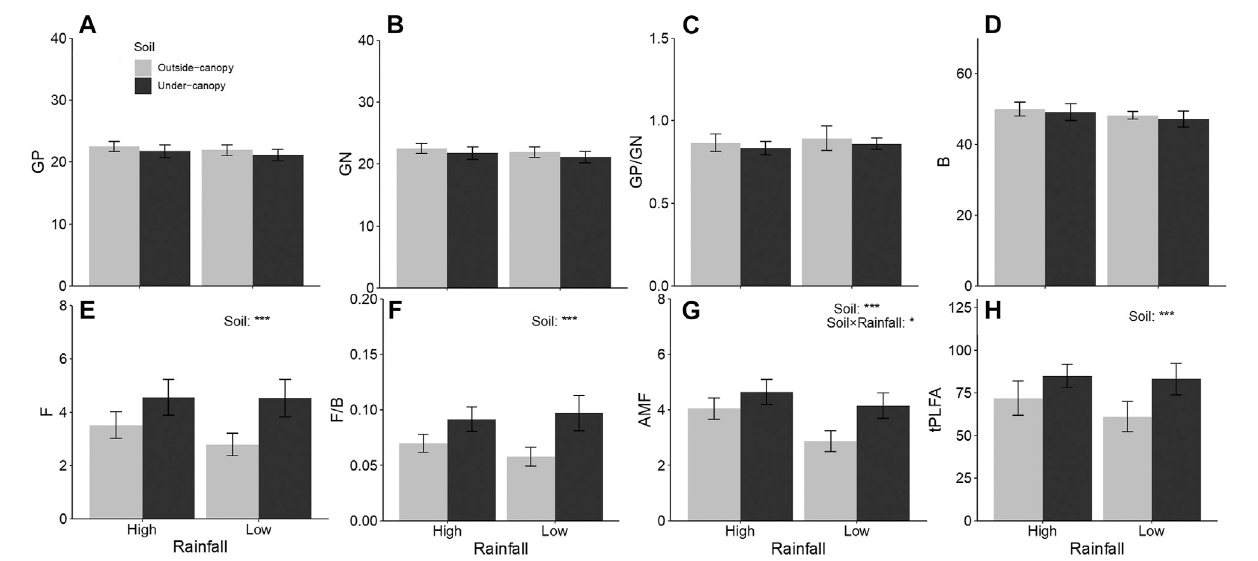
FIGURE 1 | Difference (mean ± CI) in abundance of microbial groups indicated by PLFA (phospholipid fatty acids) biomarkers in soil under (Under-canopy, dark gray bars) and outside the canopy (Outside-canopy, light gray bars) of shrub species Artemisia gmelinii from sites of low and high rainfall. Total abundance of soil microbes(tPLFA)wasexpressedinnanomolespergramofdrysoils,andabundanceofeachmicrobialgroupwasexpressed asitspercentage ofthetPLFA. GP,Gram- positivebacteria;GN,Gram-negativebacteria;B,totalbacteria;F,saprotrophicfungi;F/B,ratioofsaprotrophicfungaltobacterialabundanceandAMF,arbuscular mycorrhizal fungi. Statistical results are shown in Table 1 .